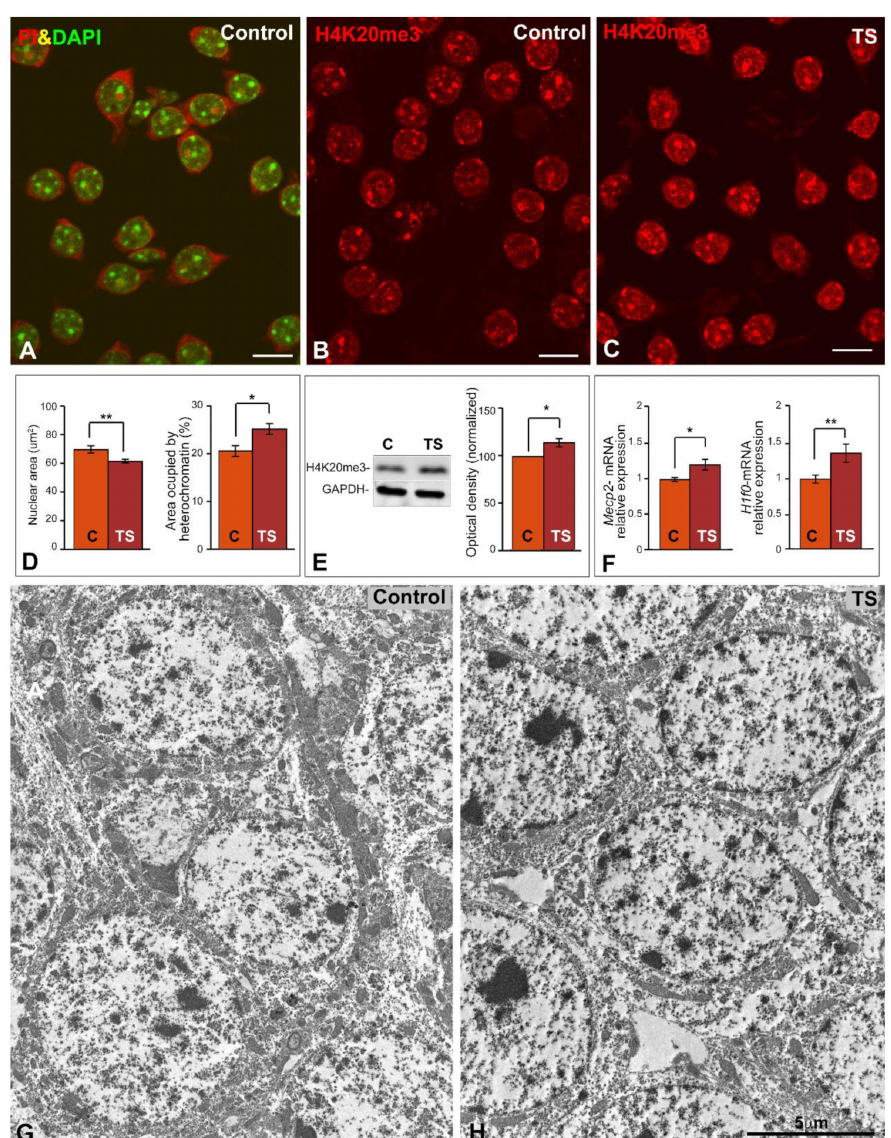
Figure 1. GCs of TS mice show reduced nuclear size and increased heterochromatinization. ( A ) Representative example of dissociated dentate gyrus GCs from a control mouse co-stained with DAPI (DNA staining) and propidium iodide (PI, RNA staining). Note the well-preserved neuronal perikarya, illustrating the concentration of RNA in the cytoplasm and nucleoli, and the prominent heterochromatin clumps counterstained with DAPI. ( B , C ) Histone H4K20me3 immunola- beling of dissociated GCs from control ( B ) and TS mice ( C ). Note the higher nuclear fluorescent signal of this trimethylated histone in TS GCs. Scale bars: 5 µ m. ( D ) Morphometric analysis of the nuclear size and the nuclear surface area occupied by histone H4K20me3-positive clumps in control and TS GCs. Partial trisomy in TS mice associates with a reduction of nuclear size and a parallel increase of repressive heterochromatin domains. ( E ) Up-regulation of histone H4K20me3 expression in the hippocampi of TS mice relative to control animals as shown by Western blotting. GAPDH was used as loading control. ( F ) RT-qPCR determination of Mecp2 and H1f0 gene expression in hippocampal RNA extracts from control and TS mice. Both genes are up-regulated in the TS mice. ( D – F) : Data is presented as means + SEM of three independent experiments. ( G , H ) Electron micrographs of GCs from control ( G ) and TS ( H ) mice. Note the prominent heterochromatin clumps in TS GCs. Scale bar: 5 µ m. *: p < 0.05, **: p < 0.01. C = control mice; TS = Ts65Dn